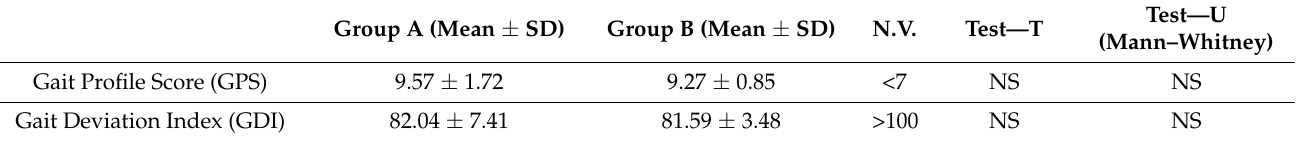
Table 5. GPS and GDI qualitative walking indexes. No significant variation between Group A and Group B patients was found; even globally for both TKA patients, we did not find any value different from normal values.